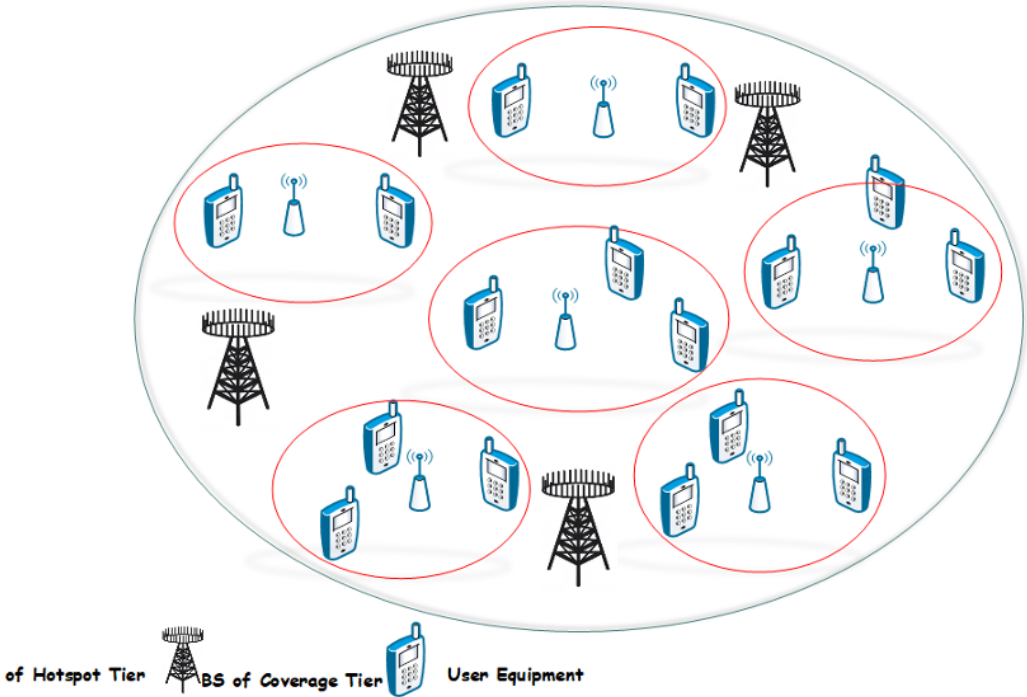
Figure 2. Illustration of hotspot tier and coverage